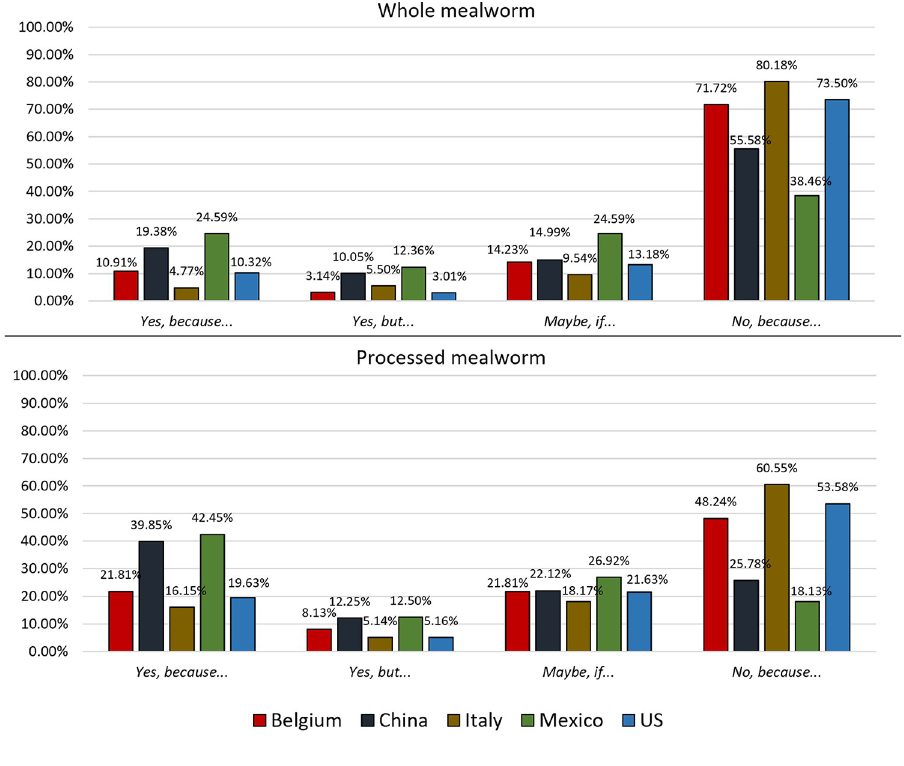
Fig 5. Acceptance level (%) of the introduction of mealworms, either whole or processed, into the diet of the five different countries (Belgium, China, Italy, Mexico, and the US).